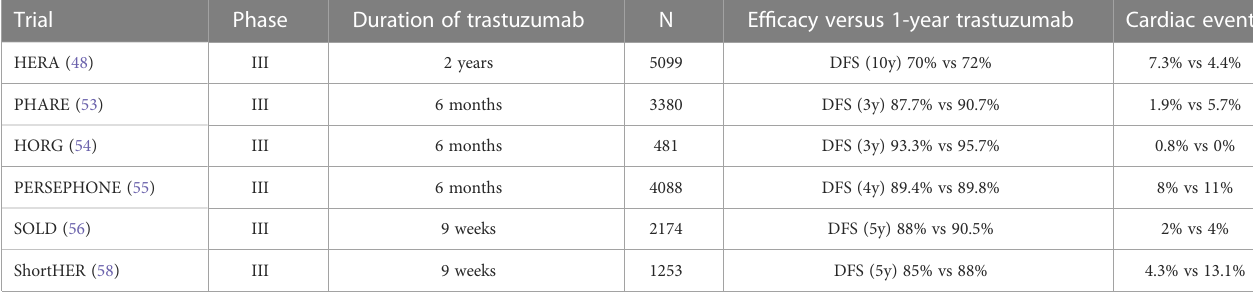
TABLE 2 Trials investigating the duration of anti-HER2